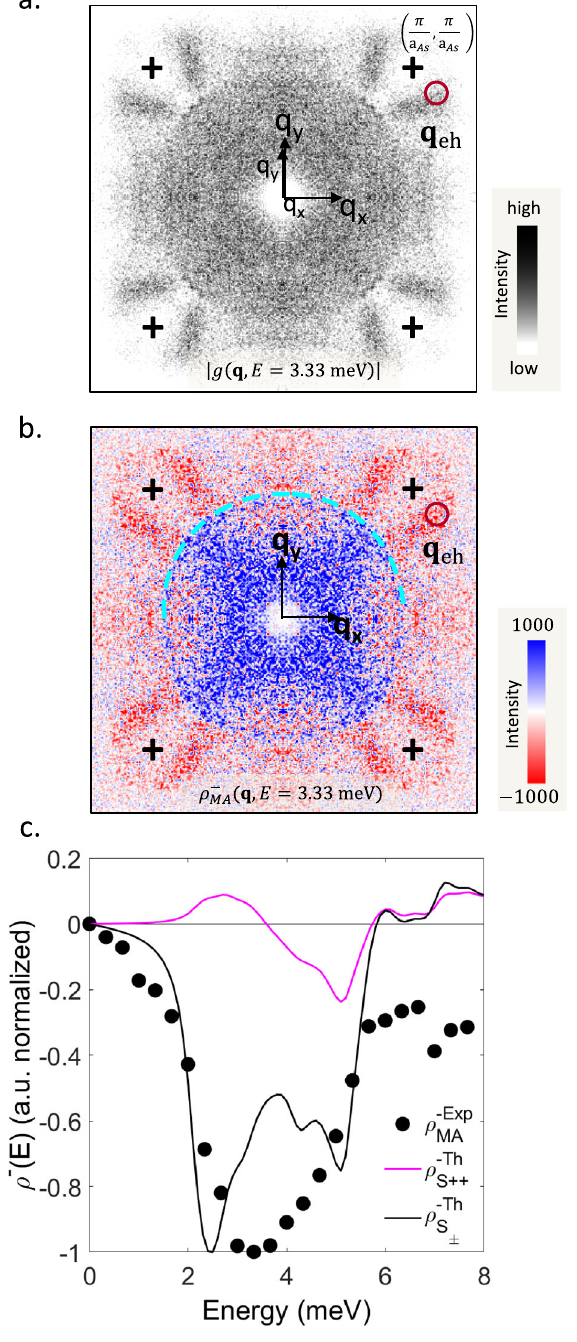
Fig. 4 LiFeAs superconducting energy-gap symmetry from MAHAEM. a The measured | g ( q )| pattern recorded in the FOV with multiple atomic scattering sites. The hole-like to electron-like scattering as predicted in Fig. 3c is detected clearly and indicated by a brown circle at the same location as 3c. The features inside the circle do not appear identical because the intensity in real experimental data falls off at higher | q |, while the theoretical simulation is replicated about the q-space Brillouin zone boundary with the same intensity, creating a non-physical equal intensity re fl ected feature. A Gaussian mask of σ = 0.68 Å − 1 = 0.8 π / a is used to suppress the | g ( q )| data in the | q | ≈ 0 core region, to allow clearer presentation of the high-| q |- under study. Much of this | q | ≈ 0 signal intensity is believed to emanate from long-range disorder and is, moreover, unrelated to the scienti fi c objectives of this paper. b The measured ρ (cid:2) ð q ; E ¼ 3 : 33meV Þ using Eq. (9); it is typical of all MA ρ (cid:2) q ; E Þ between 1 and 6 meV. The circle indicates the hole-like to MA ð q ; E Þ over the electron-like scattering in a . We integrate the ρ (cid:2) MA ð range of q within this region. The dashed lines are guide to eye to a feature which is consistent with intra h 3 scattering. Again, a Gaussian mask of σ ¼ 0 : 68 Å (cid:2) 1 ¼ 0 : 8 π = a is used to suppress the intense core emanating from long range disorder, to allow clearer q ; E ð Þ information at high-| q |. This sup- presentation of the ρ (cid:2) MA pressed area corresponds to ~18% of the total area of the fi rst q - space Brillouin zone, and the unprocessed ρ (cid:2) ð q ; E Þ data for this MA fi gure are provided in its entirety at Supplementary Fig. S6a. c The E Þ calculated by summing over the oval enclosed resulting ρ (cid:2) MA ð region in b (black dots), and the theory curves (solid) for s ± (black) and s ++ (pink) overlaid. Clearly, this demonstrates using MAHAEM that the superconducting energy gap symmetry of LiFeAs is s ±